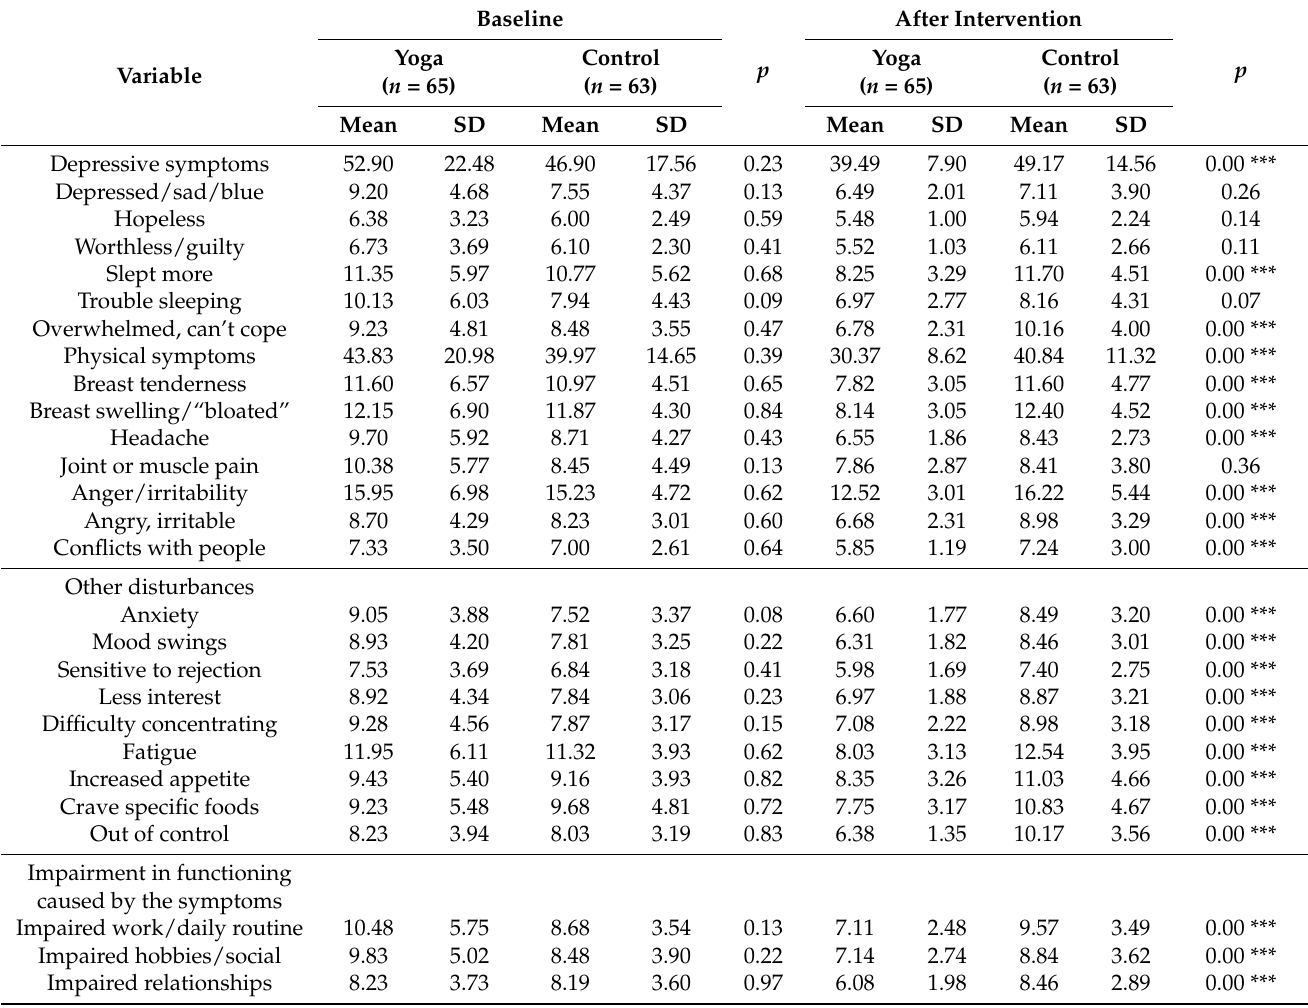
Table 2. Comparison of premenstrual symptoms of the participants in both